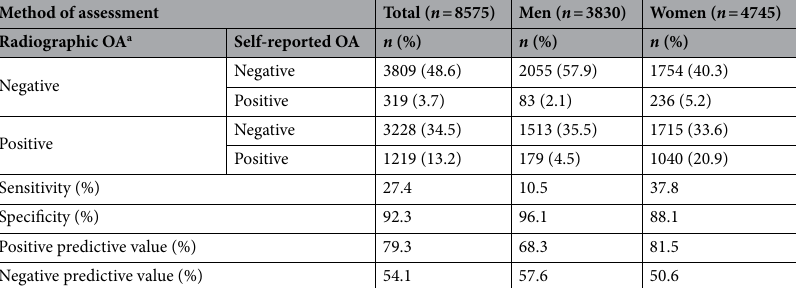
Table 3. Agreement between radiographic and self-reported OA in adults 50 years and older in KNHANES 2010–2013. Radiographic OA is the gold standard to diagnose OA. Data are shown as unweighted n (weighted percentage). Sample weights were applied according the directions of the KNHANES. KNHANES, Korea National Health and Nutrition Examination Survey; OA, osteoarthritis. a Joints assessed for radiographic OA include the knee, lumbar spine, and